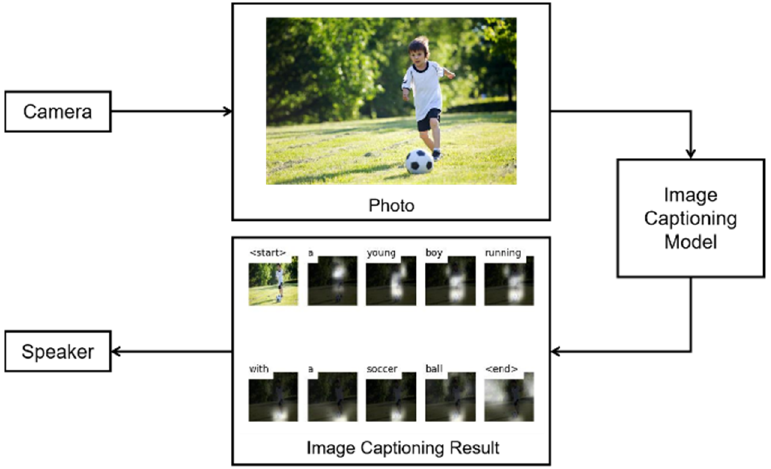
Figure 11. Image captioning function realization process.